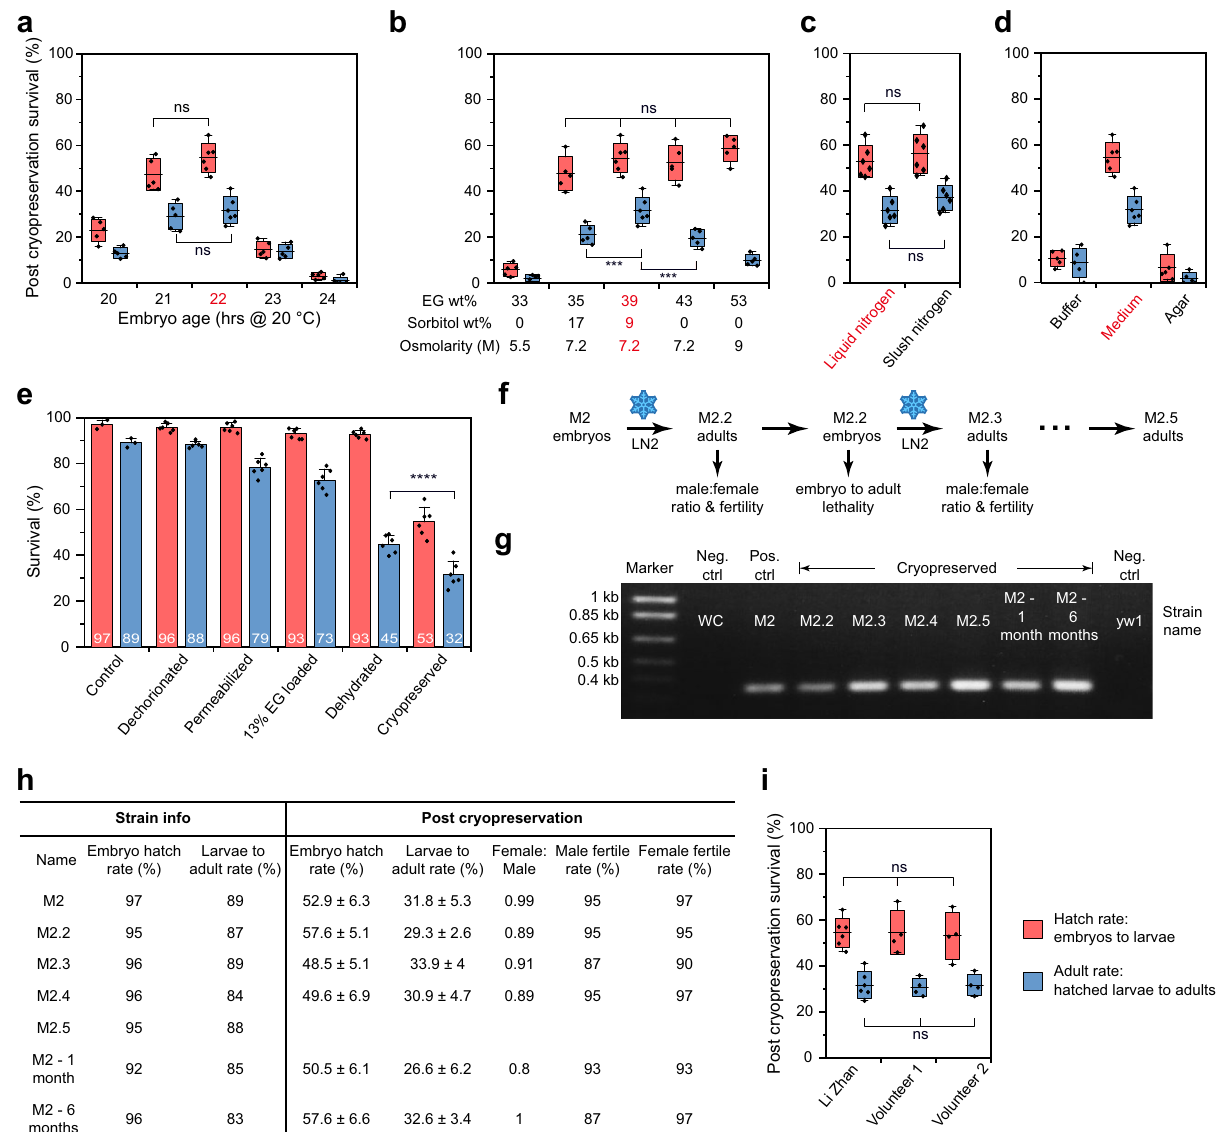
Hatch rate: embryos to larvae Adult rate: hatched larvae to